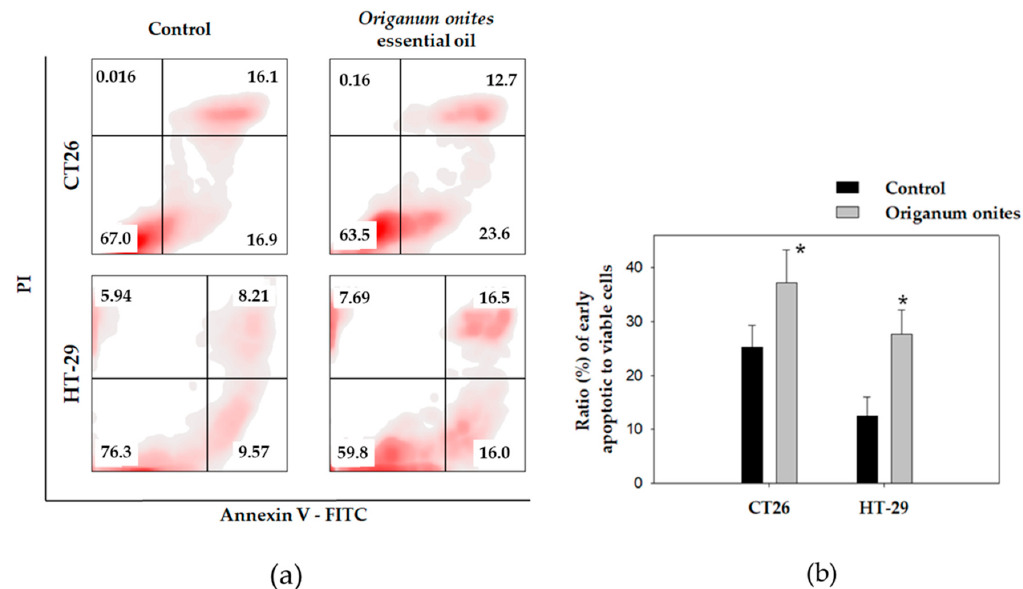
Figure 4. OOEO induces apoptotic cell death in colon cancer cells detected by flow cytometry. CT26 or HT-29 cells were treated with 71.70 or 58.00 µ g / mL of the oil, respectively, for 24 h. Apoptotic cell death of cells was detected by dual staining with Annexin V-FITC and PI followed by flow cytometric analysis. ( a ) The percentages of the following cell populations are indicated on the respective density plots: Annexin V-FITC and PI negative stained, indicating viable cells (lower left quadrant), Annexin V-positive and PI-negative stained, indicating early apoptotic cells (lower right quadrant), and Annexin V / PI double-stained cells, showing late apoptosis (upper right quadrant). ( b ) Ratio percentage of early apoptotic to viable cells for each cell line. At least 10,000 cells were analyzed per sample. Results are presented as the mean ± SD of three independent experiments. Asterisks indicate statistically significant difference between control and treated cells ( p < 0.05, Student’s t-test).